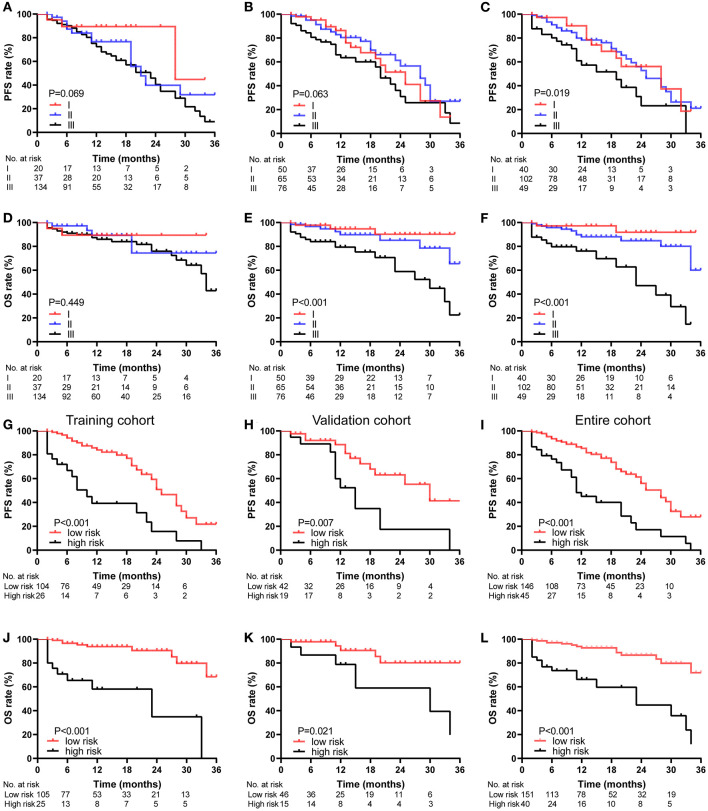
Kaplan-Meier survival curves of the NDMM patients, categorized by different staging systems. PFS (A–C) and OS (D–F) curve of the D-S (A,D), ISS (B,E) and R-ISS (C,F) stage in entire cohort. PFS (G–I) and OS (J–L) curve of the nomogram stage in training cohort (G,J), validation cohort (H,K), and entire cohort (I,L).